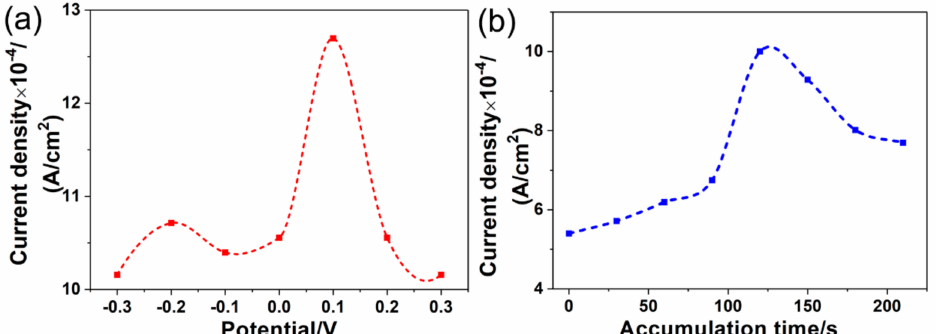
Figure 6. E ff ects of the accumulation potential ( a ) and the accumulation time ( b ) on the oxidation peak currents of 1.0 × 10 − 5 mol / L tryptophan at Ta 2 O 5 -rGO /